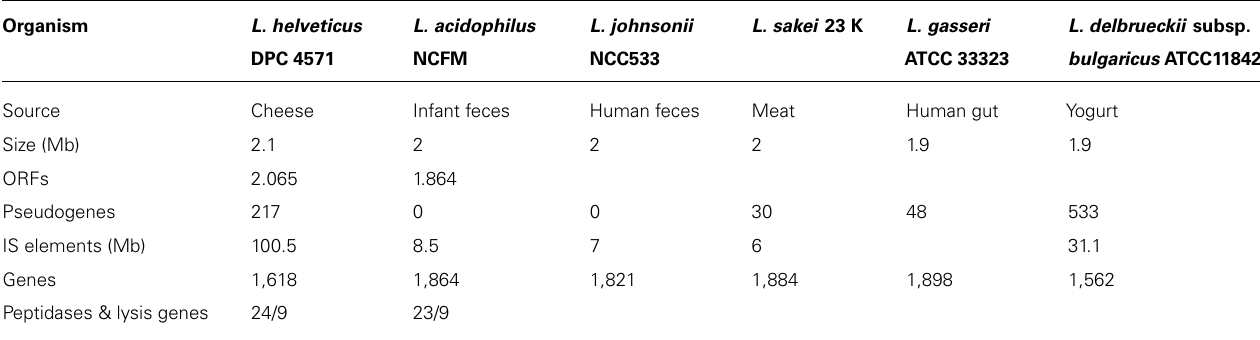
Table 2 | Comparison between the genomes of L. helveticus DPC 4571 and others Lactobacilli (LAB).